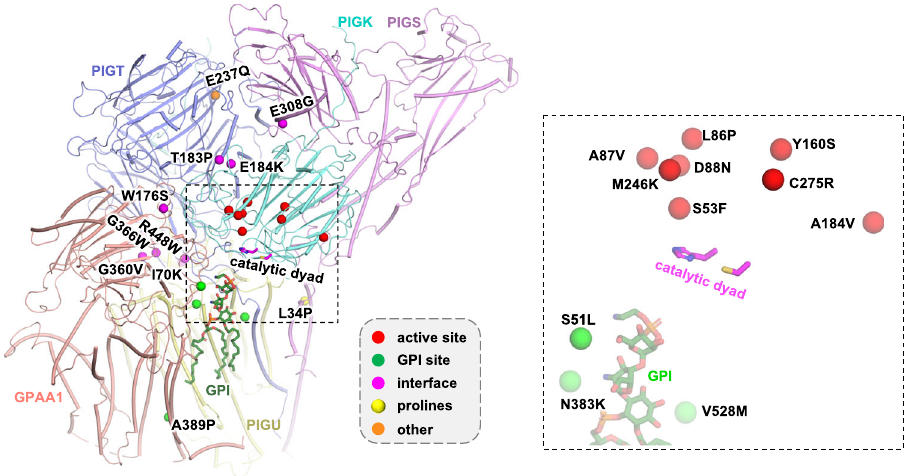
Fig. 7 Distribution of genetic mutations on GPI-T. Mapping the disease mutations (C α spheres, color-coded by the categories in the gray box) onto the human GPI-T structure (main chain, color-coded cylinder representations; catalytic dyad, magenta stick presentations; GPI, green stick representations). The mutations include PIGK S53F/L86P/A87V/D88N/Y160S/A184V/M246K/C275R that cause a neurodevelopmental syndrome with hypotonia, cerebellar atrophy, and epilepsy 28 , PIGT T183P that causes an intellectual disability syndrome 31 , PIGT E184K/G360V/R448W that are related to the Multiple Congenital Anomalies-Hypotonia Seizures Syndrome 3 32, 35, 36 , PIGT E237Q/V528M that cause developmental disorders characterizing learning disability, epilepsy, microcephaly, congenital malformations and mild dysmorphic features 33 , PIGT G366W that is found in patients with epileptic apnea and multiple congenital anomalies, severe intellectual disability, and seizures 34 , PIGS L34P/E308G that are related to a neurological syndrome ranging from fetal akinesia to epileptic encephalopathy 30 , PIGU I70K/N383K that are found in patients with severe intellectual disability, epilepsy, and brain anomalies 29 , and GPAA1 S51L/W176S/A389P that are also related to developmental disorders featuring global developmental delay, epilepsy, cerebellar atrophy, and osteopenia 37 . Left, overview with a box showing the area close to the active site. Right, the expanded view of the boxed region on the